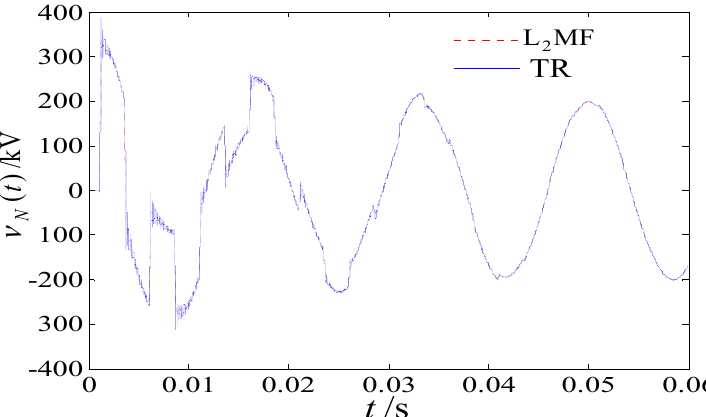
Figure 8. Terminal voltage of the transmission line calculated by the four-step L 2 MF method and the implicit trapezoidal integration method.